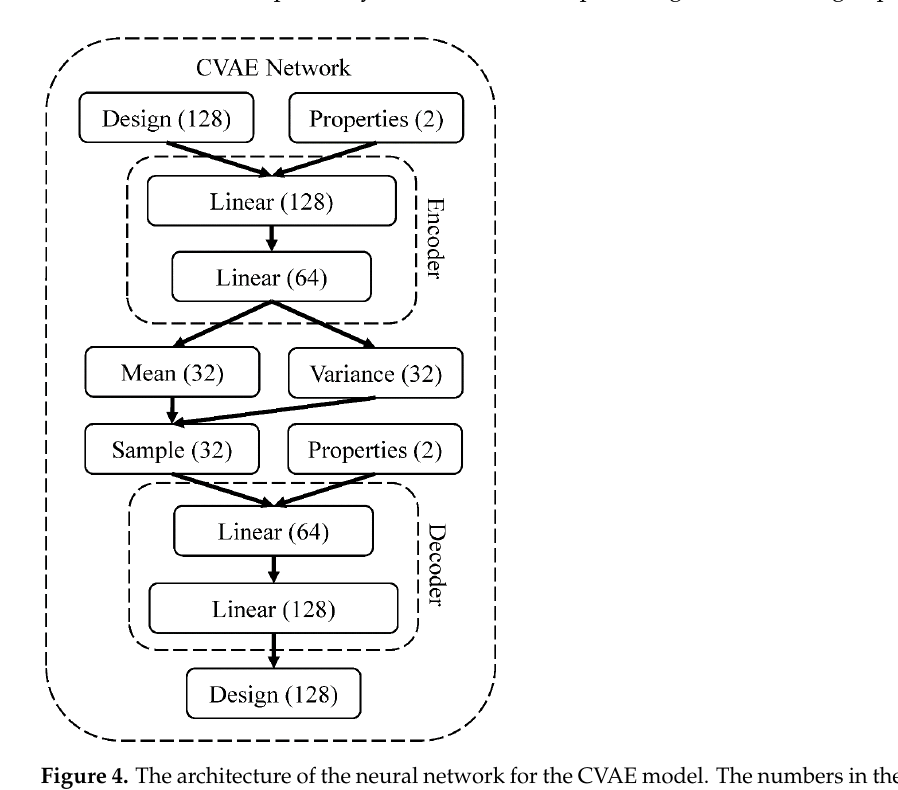
Figure 4. The architecture of the neural network for the CVAE model. The numbers in the parentheses are the hidden units.